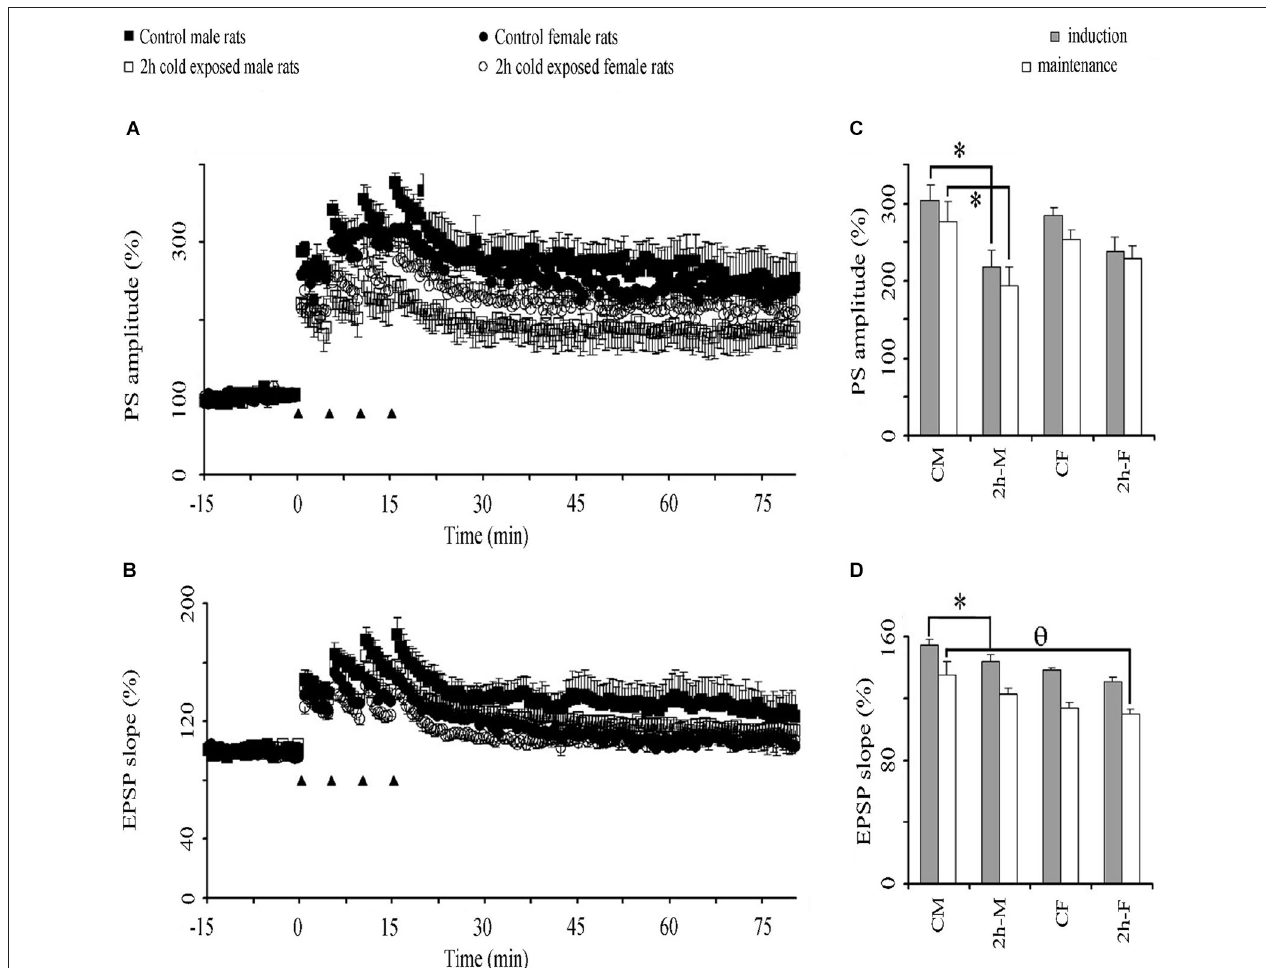
(black triangles) induced potentiation of PS in the DG in all groups. Each symbol or bar represents the mean ± SE of six rats. * represents significant difference from PS amplitude of control male rats; θ significant difference from EPSP slope of control male